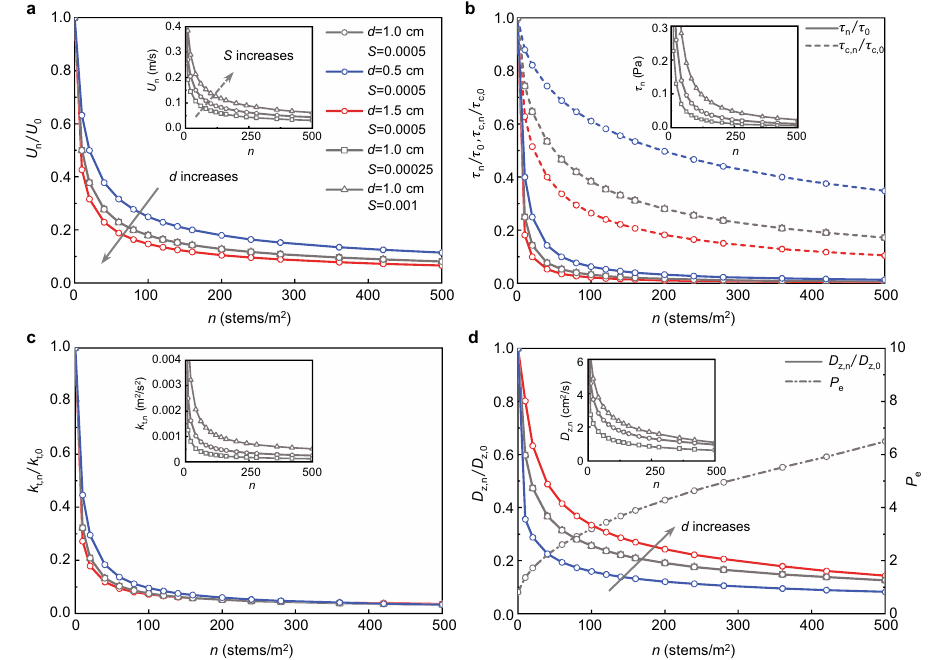
Fig. 2 | Changes in fl ow parameters with increasing vegetation area density, n . Each parameter is normalized by its value without vegetation (bare bed), denoted by subscript “ 0 ” . a Normalized velocity ( U n / U 0 ) decreases with increasing stem density n . Blue to red color represents increasing diameter or slope. The normal- ized velocity is not a function of slope (Eq. (M4)), so all cases with the same stem diameter but different slopes collapse to a single curve, shown by the gray curve. The inset graph shows the dimensional velocity U n for different slopes with